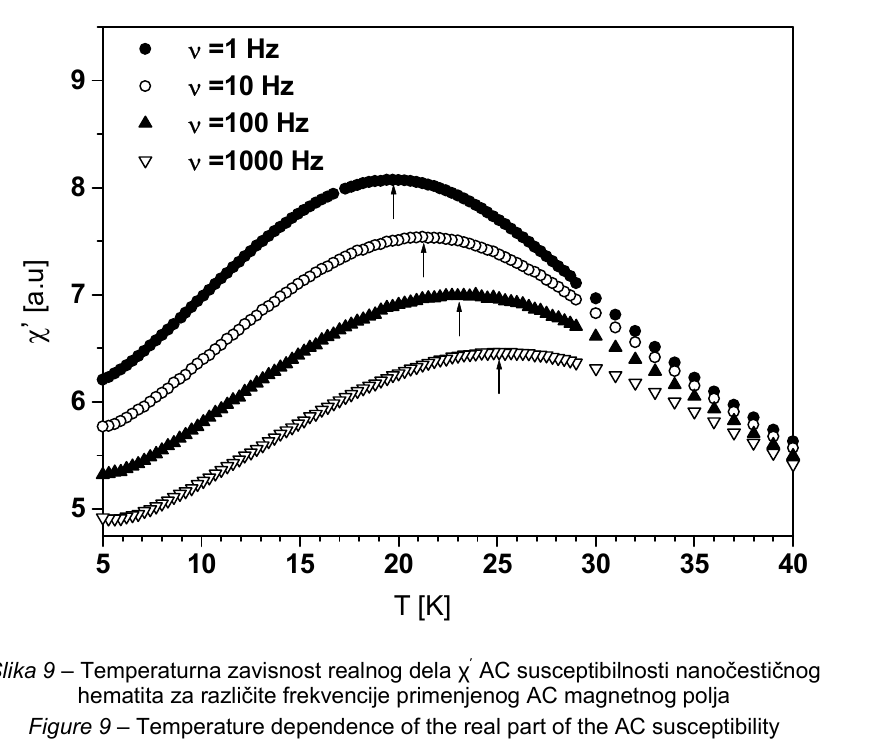
Figure 9 – Temperature dependence of the real part of the AC susceptibility at different frequencies. The arrows denote the positions of TB